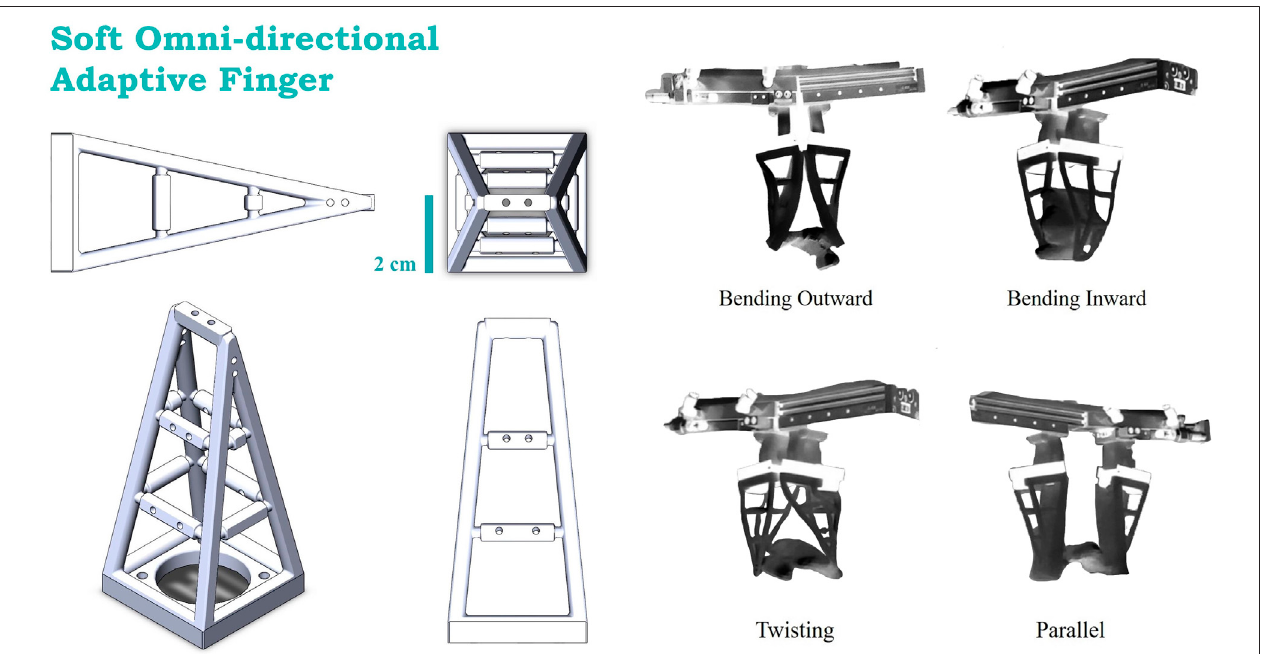
FIGURE 3 | The execution unit that will be used in this paper, which is a network structure built by soft material, following with its 4 grasping poses.